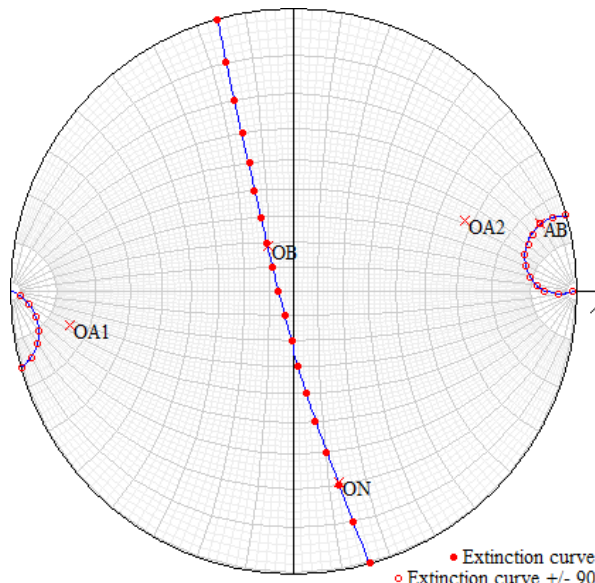
Figure 3. Graphical output plotted by EXCALIBRW obtained from the extinction data of a mullite-2 c crystal. This crystal is from the same rock sample as the specimen investigated by single-crystal X-ray diffraction and EMPA. The stereographic projection shows the observed extinction positions (solid and hollow dots) including the calculated extinction curves and the orientation of the optical axes (OA1 and OA2) as well as the directions of the three principal axes of the biaxial indicatrix, AB, OB and ON, which represents the acute bisectrix, obtuse bisectrix and optic